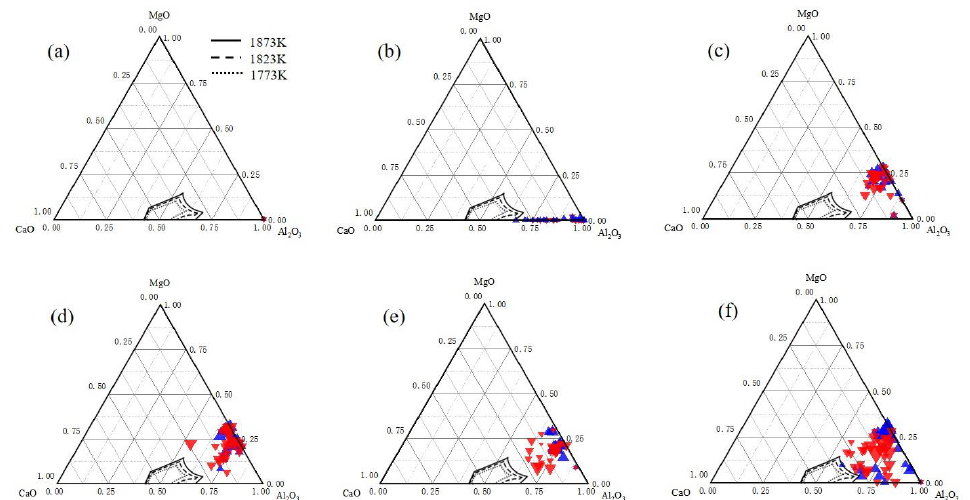
Figure 3. Composition of inclusions when adding Mg after Ca ( a ) 30 s after Al addition, ( b ) 30 s after Ca addition, ( c ) 30 s after Mg addition, ( d ) 5 min after Mg addition, ( e ) 15 min after Mg addition, ( f ) 30 min after Mg addition.